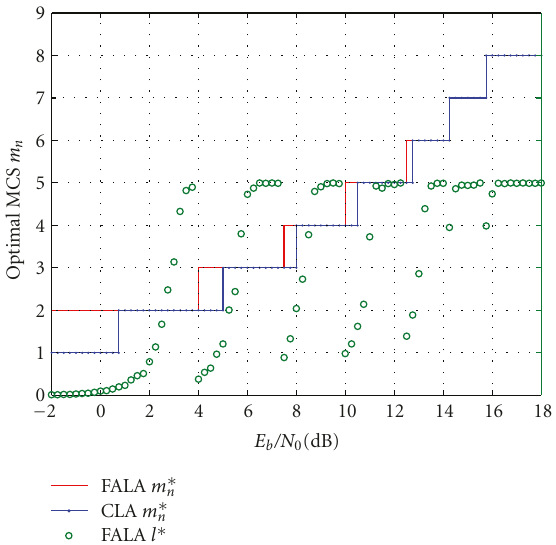
Figure 6: The FALA table T : optimal selections of the MCS scheme (left axis) and the MPDU payload size l ∗ (right axis) versus the m ∗ n SNR value. The optimal MCS schemes with fixed MPDU payload size ( l = 5KBytes) is also illustrated for comparison